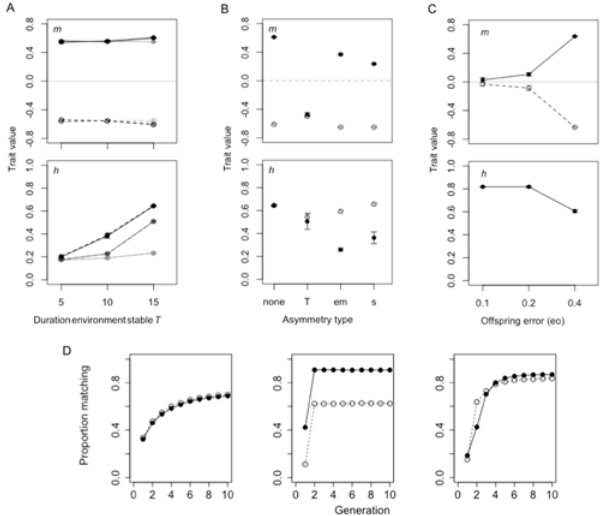
Figure 5. Locust model results. (A-C) Evolved values (mean ± SE from last 20,000 generations) for, top panel, maternal environment effects m (filled circles and solid lines denote crowded environment, hollow circles and dotted lines denote uncrowded environment) and, bottom panel, phenotype-specific transmission stability h (filled circles and solid lines represent gregarious phenotype, hollow circles and dotted lines, solitary phenotype). (A) Separate values are shown for increasing levels of maternal error (pale grey = 0.1, dark grey = 0.2, black = 0.4). (B) Labels on x-axis explain asymmetries considered, i.e. T = (15,5); em = (0.4,0.1) and s = (0.2,0.1) for (uncrowded, crowded) environments respectively. (D) Example of how to measure the hysteresis effect: proportion of matched phenotypes in the population (from one simulation run) for 15 generations following an environmental switch (i.e. duration the environment is stable), when (left) there is no asymmetry in maternal error, i.e. em = (0.4,0.4), (centre) there is asymmetry in maternal error only (em = (0.4,0.1)) but transmission stability is fixed at zero and (right) there is both asymmetry in maternal error and transmission